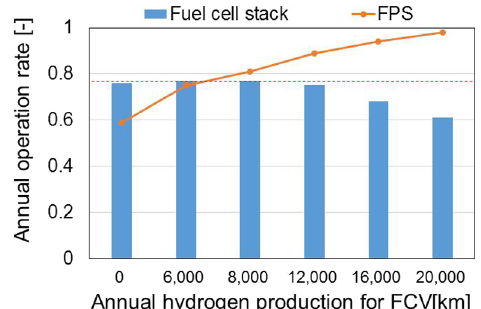
Fig. 6. Distribution of maximum hydrogen production.